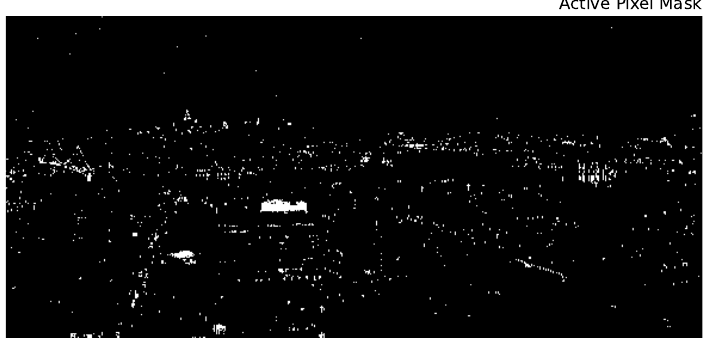
Figure 10. The pixels used in our analysis. This active pixel mask was created by thresholding the cleaned data and then thresholding a smoothed version of the result. The effect is to remove noise pixels from thresholding while maintaining the edges of extended